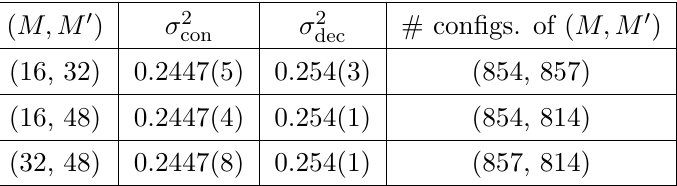
Table 2. The variances of ρ (X) and ρ (X) con in the simulation, N = 64 , T = 0 . 885 , with 24 lattice dec sites. The total number of x is obtained by # x = 64 2 × 9 × 24 × ( # configs. )